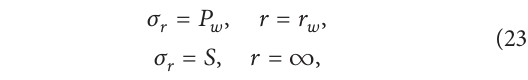
Figure 8: UCS distribution around the wellbore.